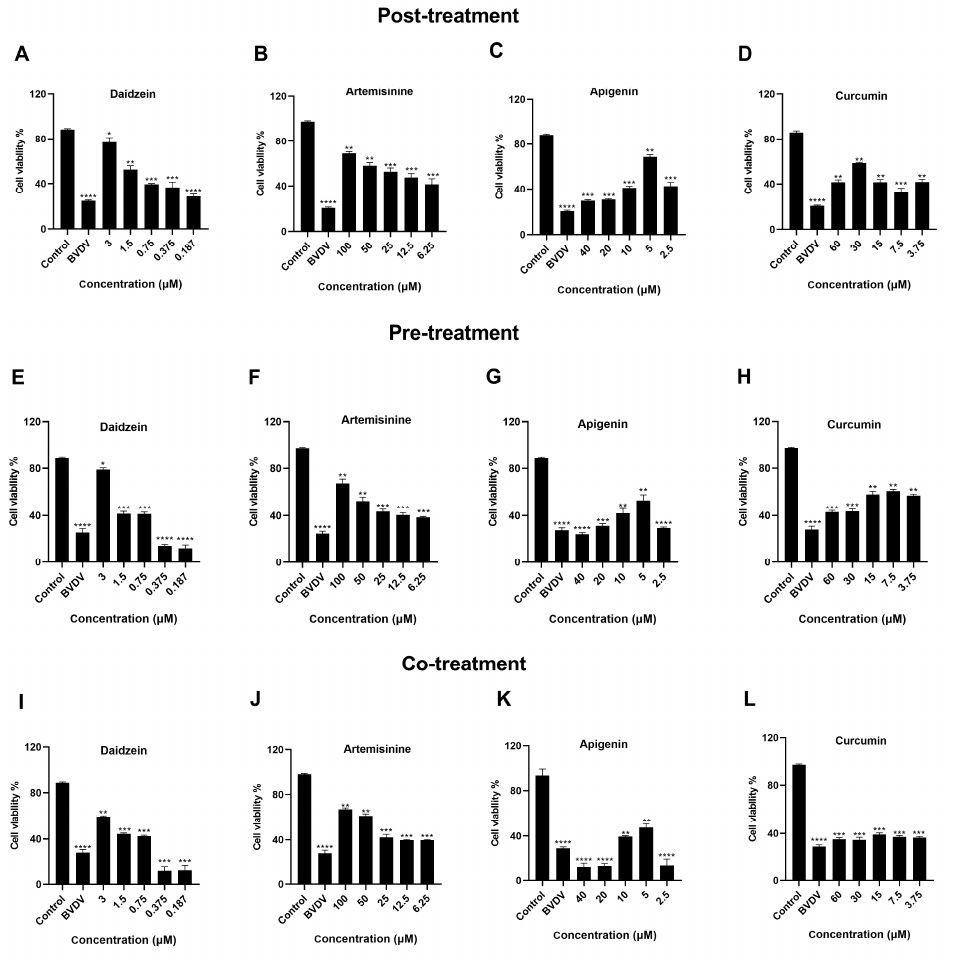
Figure 4. Results of in vitro anti-BVDV effects of Chinese herbal monomers on MDBK cell activity. ( A – D ): Effect of Chinese medicine monomeric inhibition of viral infection on MDBK cells. ( E – H ): Effect of Chinese medicine monomer to prevent viral infection on MDBK cells. ( I – L ): The combined effect of Chinese monomer and virus on MDBK cells. Post-treatment: pre-infection with the virus, then administer the medicines. Pre-treatment: pre-add the medicine, then infect with the virus. Co-treatment: medicine and virus were administered simultaneously. MOI = 1. **** p < 0.0001, *** p < 0.001, ** p < 0.01, * p < 0.05, n = 3. Data were presented as mean ± SD.